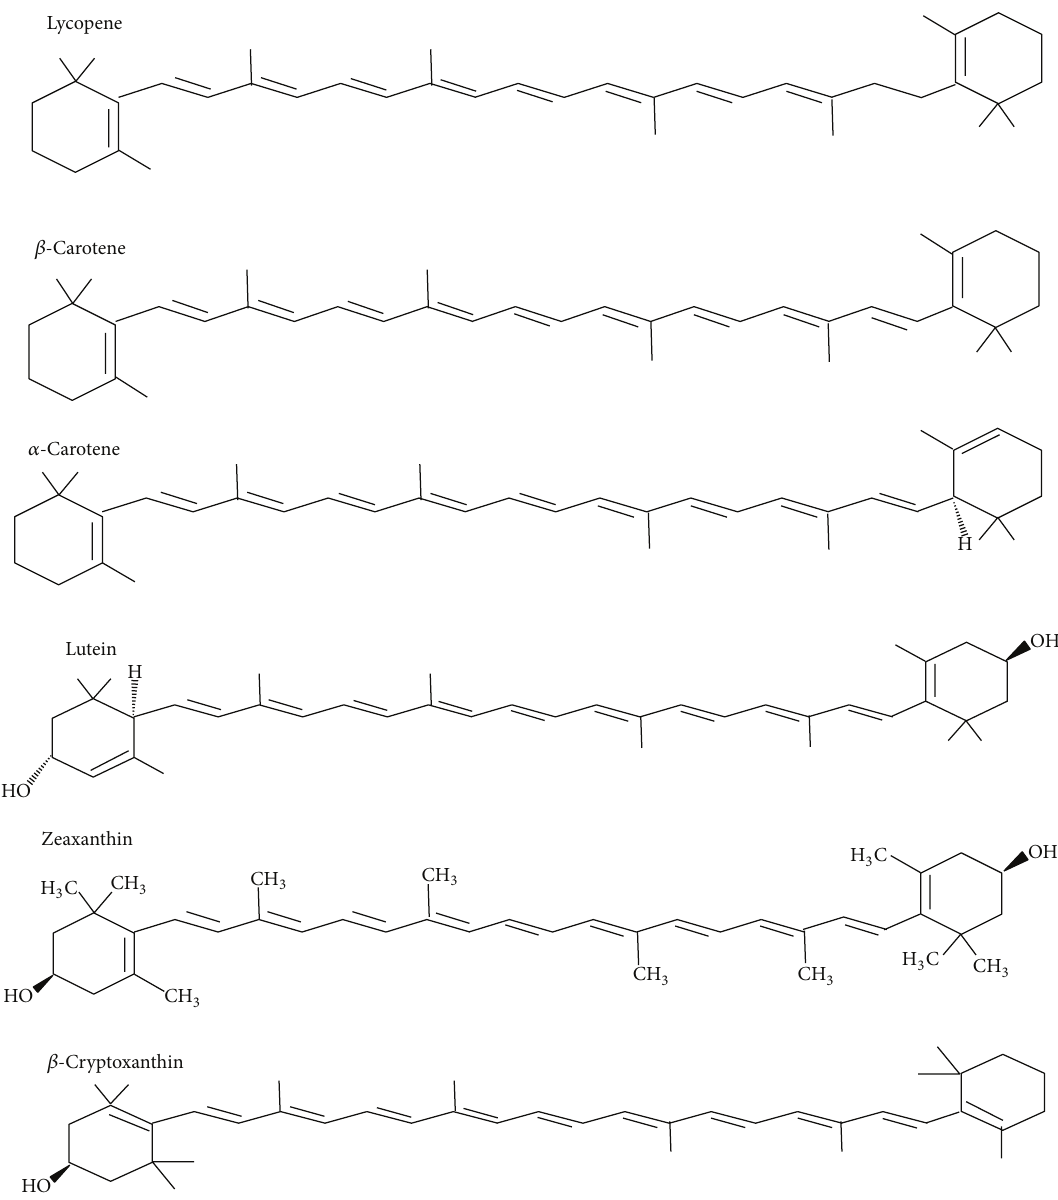
Figure 2: Chemical structures of common carotenoids in